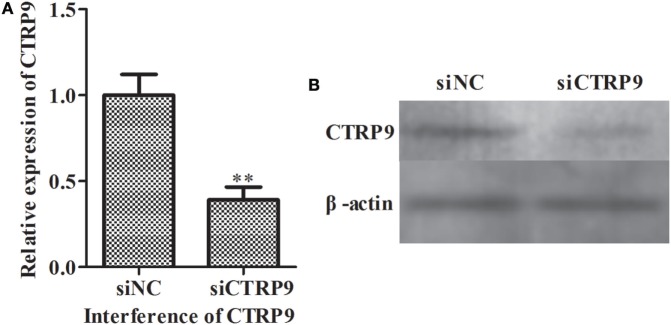
The expression level of AjCTRP9 after transfection with specific small-interfering RNAs (siRNAs). (A) Relative expression level of AjCTRP9 after AjCTRP9 siRNA transfection. (B) Western blot analysis of AjCTRPP protein after AjCTRP9 siRNA transfection. Values are given as the mean ± SD, n = 5. Asterisks indicate significant differences: *p < 0.05, **p < 0.01.